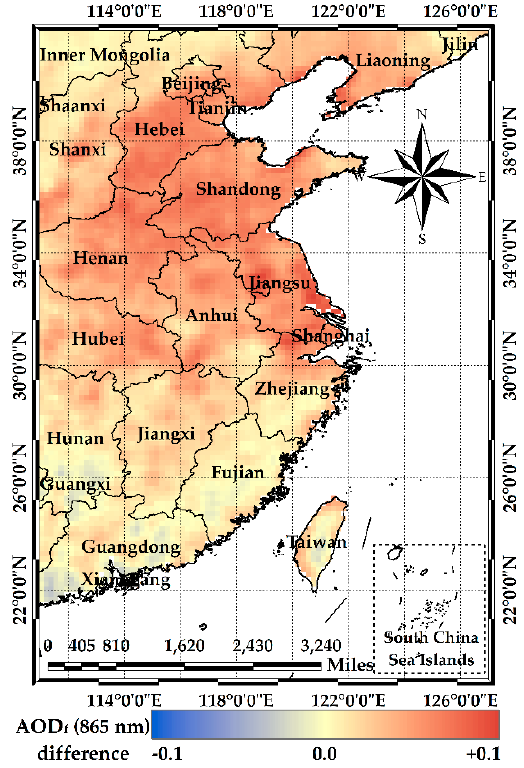
Figure 10. The absolute difference of the year-mean AOD f retrieval results between our work and PARASOL product (Retrieved AOD f minus PARASOL AOD f ).